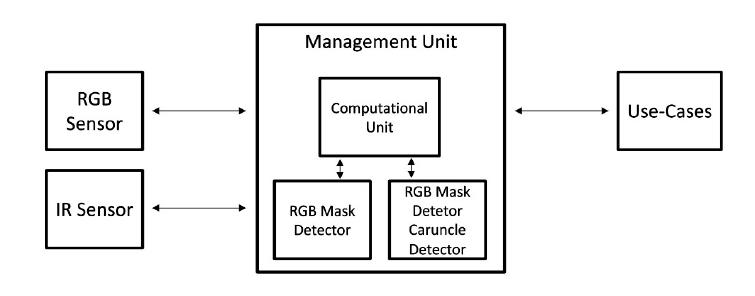
Figure 1. Architecture description of purposed